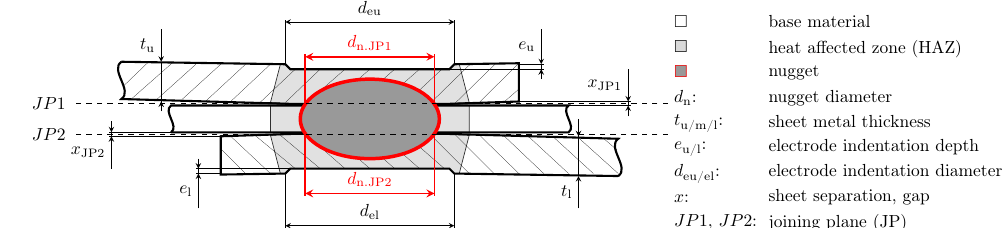
Figure 1. Schematic illustration of a spot-welded joint with three sheets and the main geometrical parameters with the highlighted nugget diameter d n as the most important